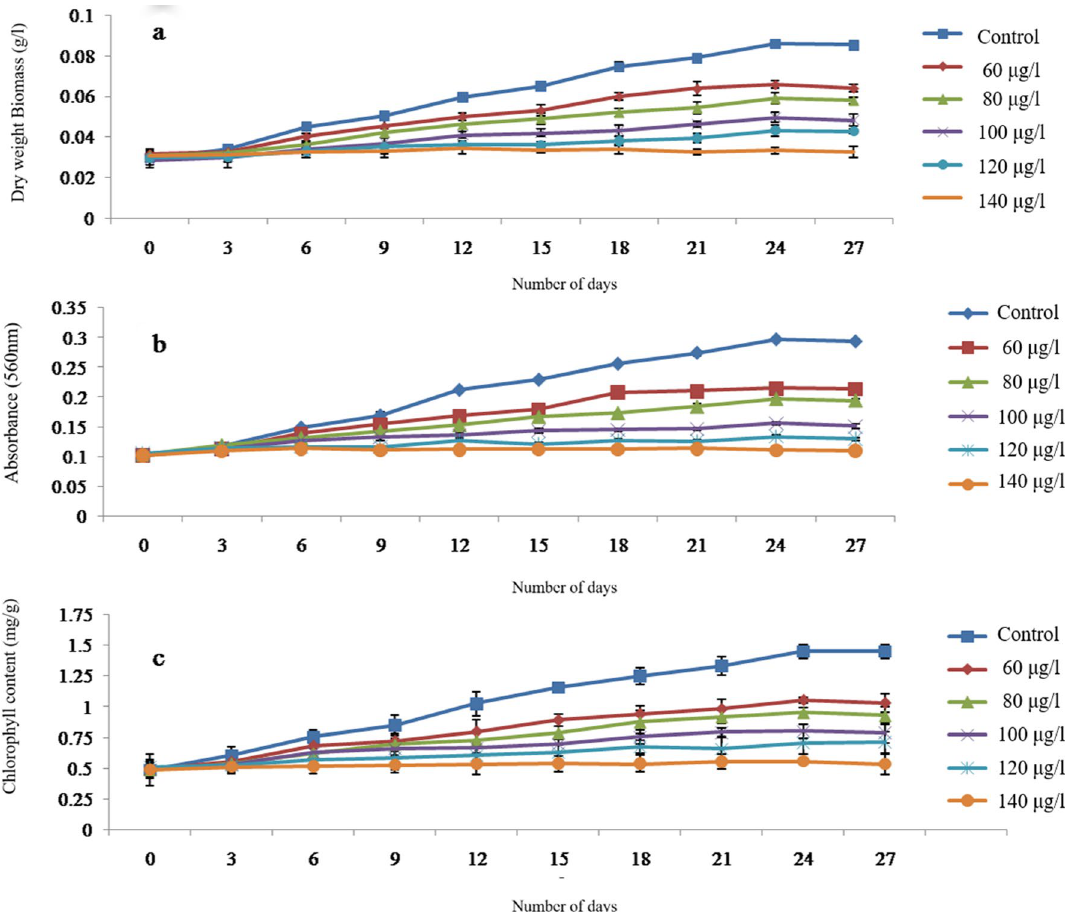
Figure 1. Effect of different concentrations of atrazine on the growth as ( a ) dry weight, ( b ) absorbance and ( c ) chlorophyll of C. stagnale . The proceeding table of Two-way ANOVA shows that 3rd day onwards